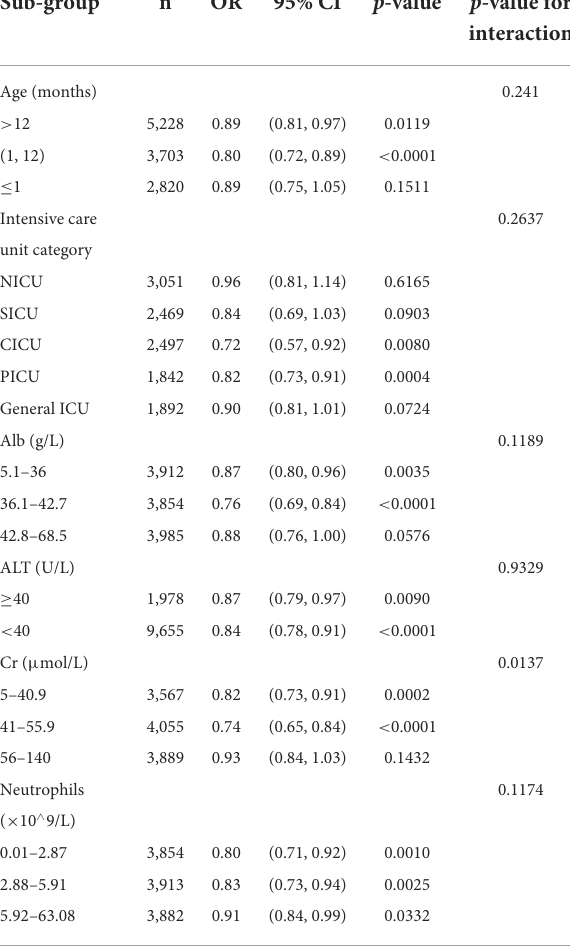
TABLE 3 Sensitivity analysis between cholinesterase per 1,000 U/L and mortality.